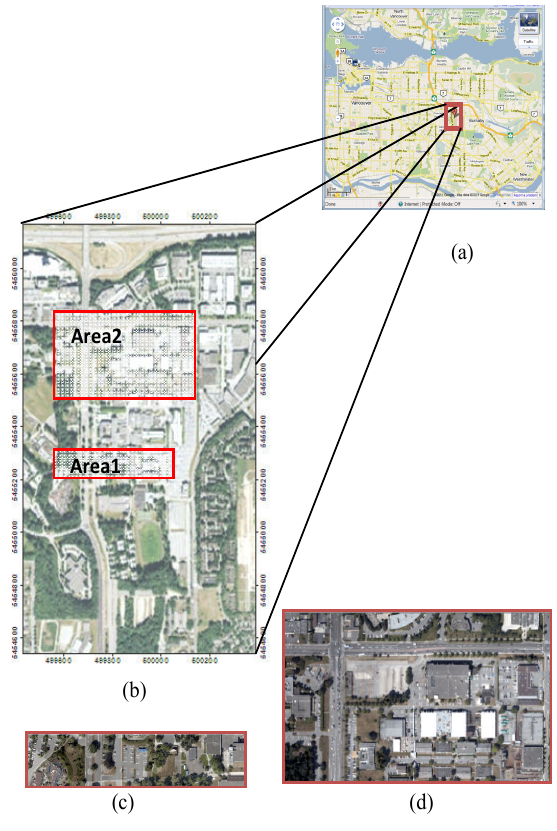
Figure 3. The Location of the Study areas as appeared in Google Map (a), and the Ortho-photo of the study area (b), Study area 1 (c), and Study area 2